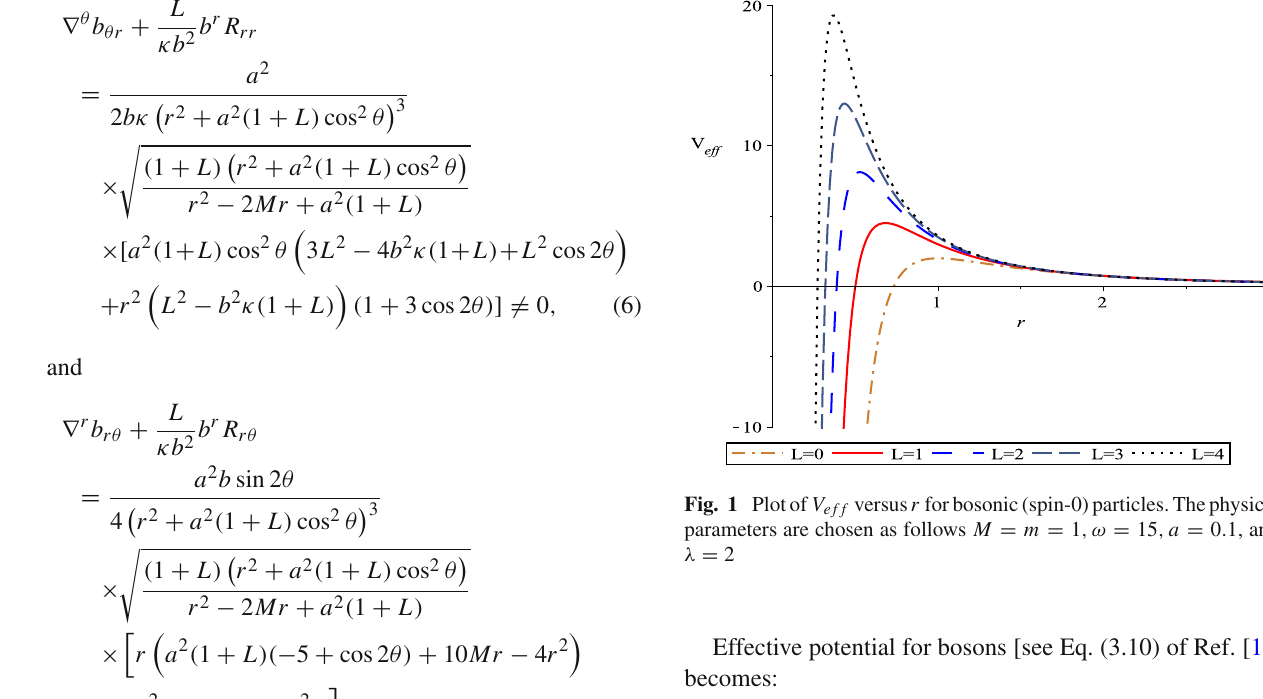
Effective potential for bosons [see Eq. (3.10) of Ref.